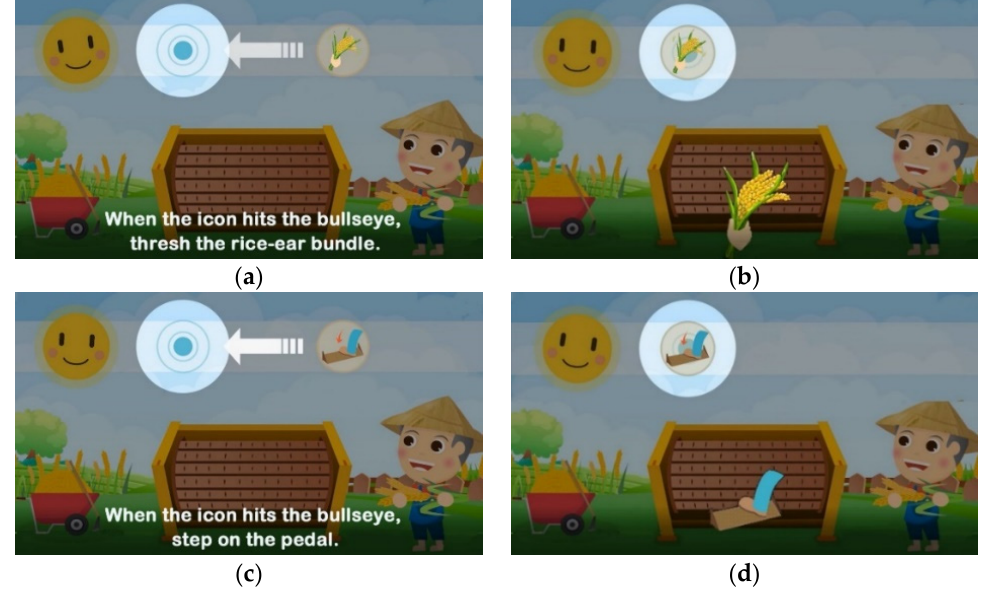
Figure 4. Illustrations on how to play the games to obtain points. ( a ) The icon of “holding the rice ear bundle” is moving to fit into the bullseye. ( b ) While the icon fits well in the bullseye, one point can be obtained by waving the rice ear bundle up and down. ( c ) The icon of “stepping on the pedal” is moving to fit into the bullseye. ( d ) While the icon fits well in the bullseye, one point can be obtained by stepping down on the pedal.